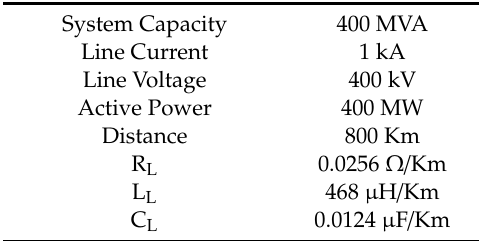
Table A1. System’s parameters used for